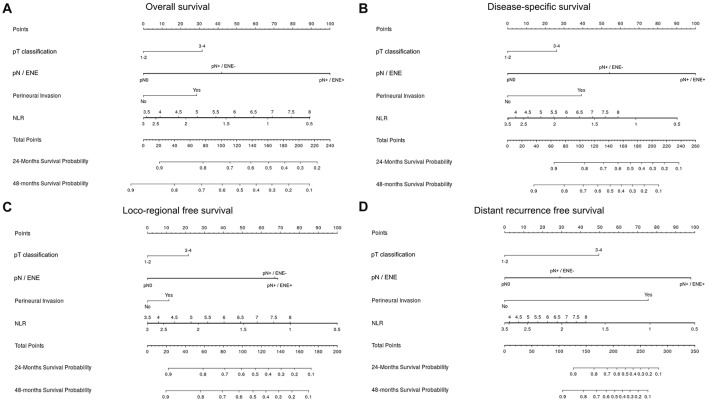
Nomogram for prediction of overall survival (A), disease-specific survival (B), loco-regional free survival (C), and distant metastasis-free survival (D). In a nomogram, a score on a scale from 1 to 100 is assigned to each covariate based on its predictive contribution to the model. Briefly, the variable that displays the strongest prognostic effect is given 100 points, and all the others receive a smaller value proportional to their size effect. The total amount of points of the single case is correlated to survival probability of the individual patient (axis in the bottom of each figure).